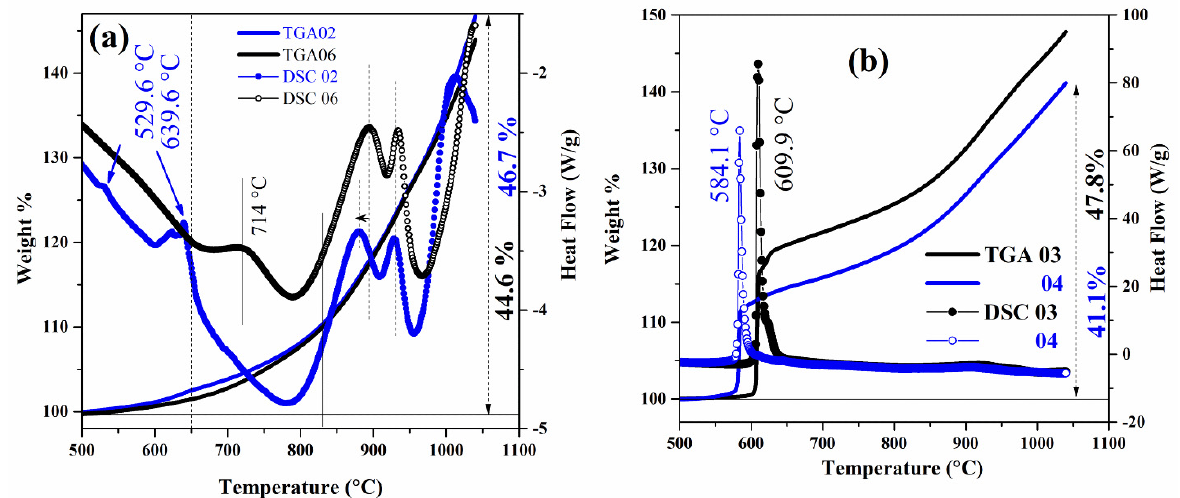
Figure 5. TG/DSC measurements in air of: ( a ) two representative samples consisting of almost pure MgB 2 (MBNB02 and MBNB06); ( b ) two representative Mg-rich samples (MBNB03 and MBNB04). Thin solid lines refer to TG, and circles correspond to DSC curves. A single color (black or blue) in the same panel identifies the same sample.